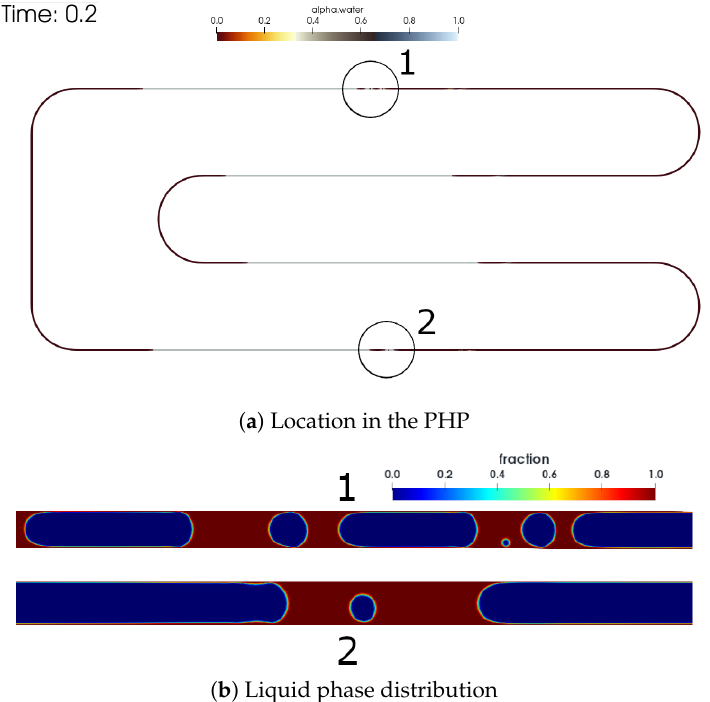
Figure 14. Numerical results of the Tanasawa model [26] in 0.2 s for 100 W input